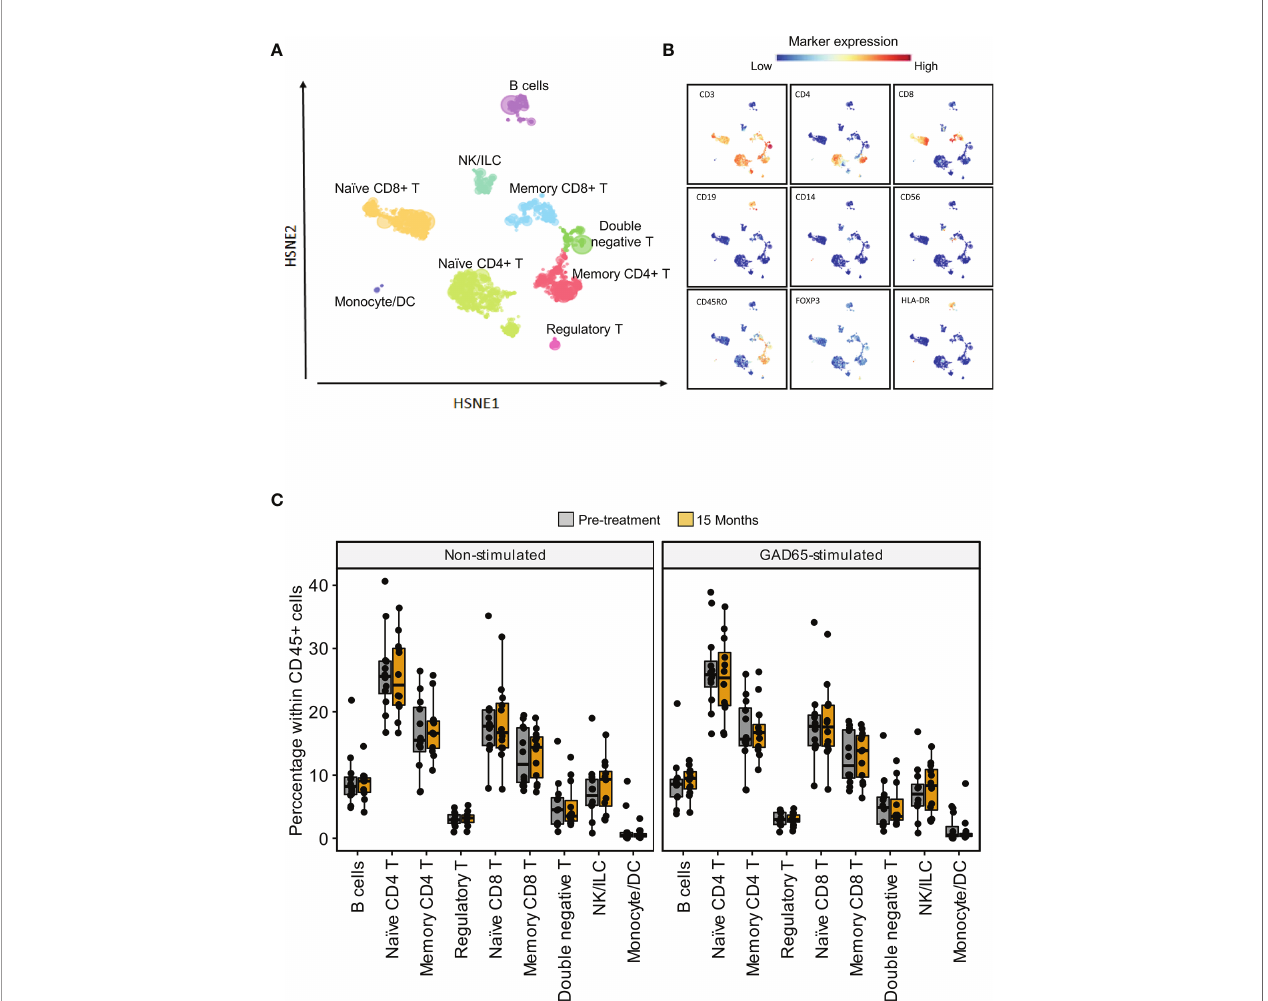
FIGURE 2 | High-dimensional analysis of the main populations within PBMCs (A) Data of live CD45+ cells were analyzed using Hierarchical Stochastic Neighbor Embedding (HSNE). Coloured areas depict nine major populations in the HSNE overview level. (B) Expression of the markers used the de fi ne major populations overlapping the HSNE overview level (C) Percentages of the major populations in non-stimulated samples (left) and samples stimulated with GAD 65 (right) before and after 15 months of